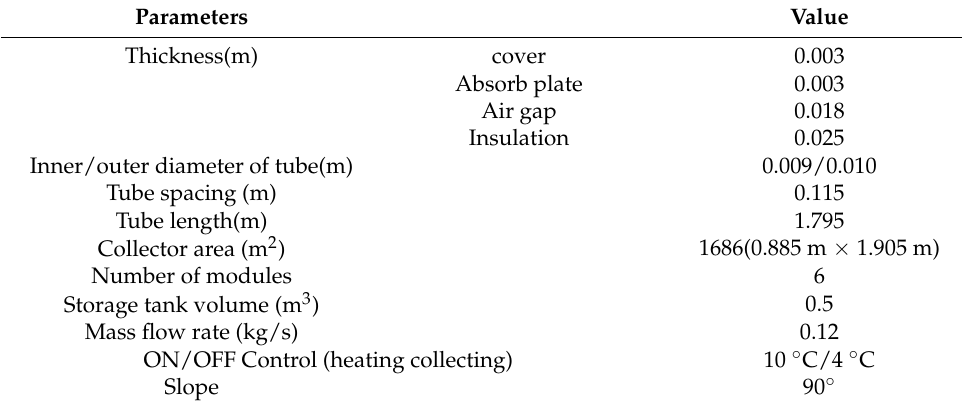
Table 2. Main parameters of the ASTF